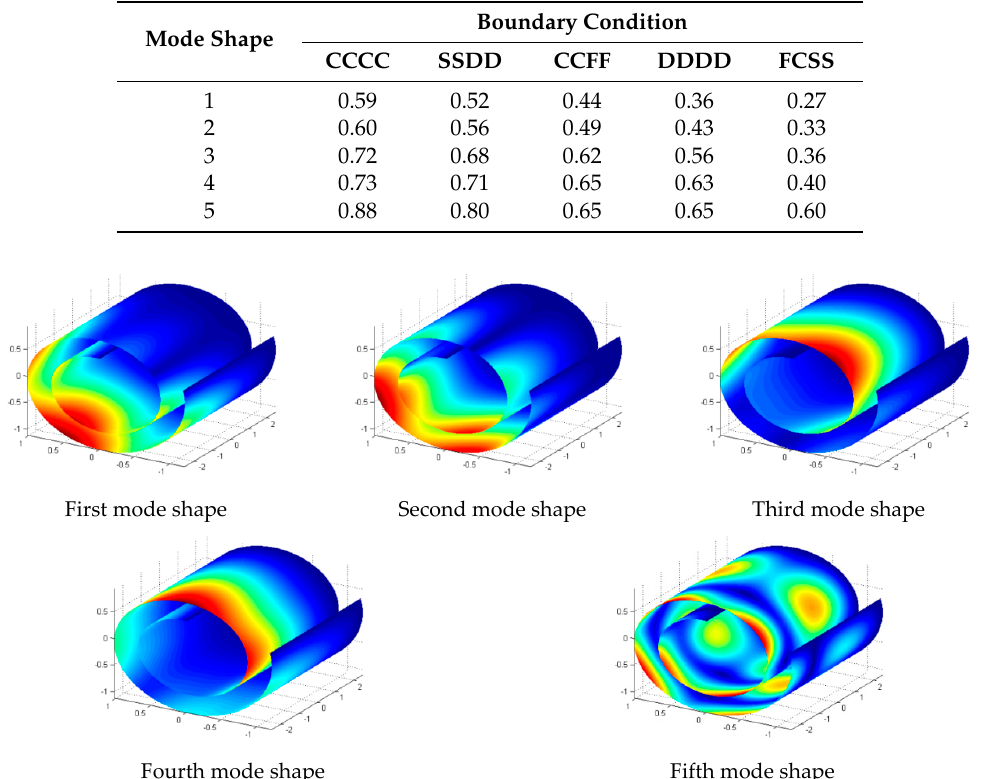
Table 2. First five natural frequencies ( T Hz ) of the CNS with different boundary conditions. Mode Shape